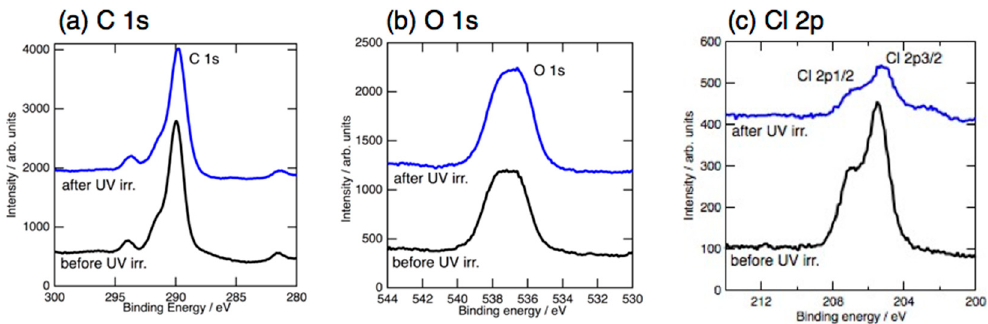
Figure 2. X-ray photoelectron spectra observed for polyvinyl 4-(chloromethyl)benzoate/MWCNT before and after ultraviolet irradiation: ( a ) C 1s, ( b ) O 1s, and ( c ) Cl 2p.